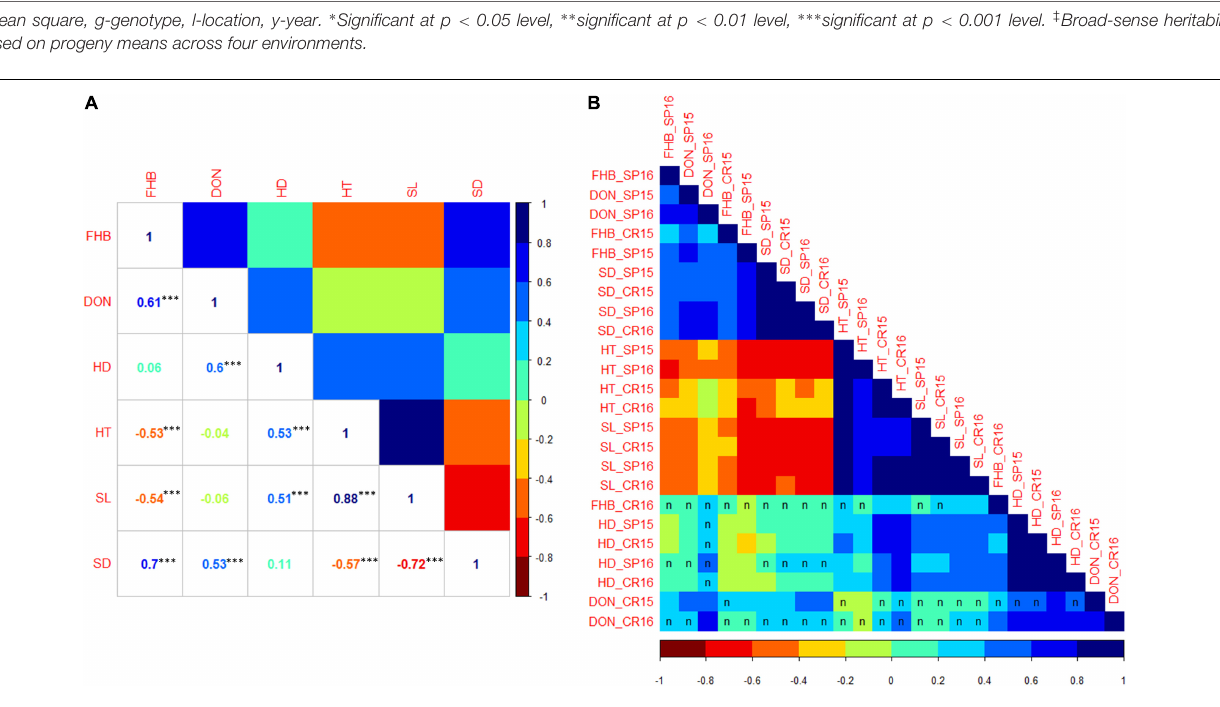
a genetic distance of 1,328 cM ( Table 3 and Supplementary Figure S2 ). The assignment and order of markers on the barley chromosomes are consistent with the iSelect 9K consensus interval for the map is 1.3 cM. There were from one to